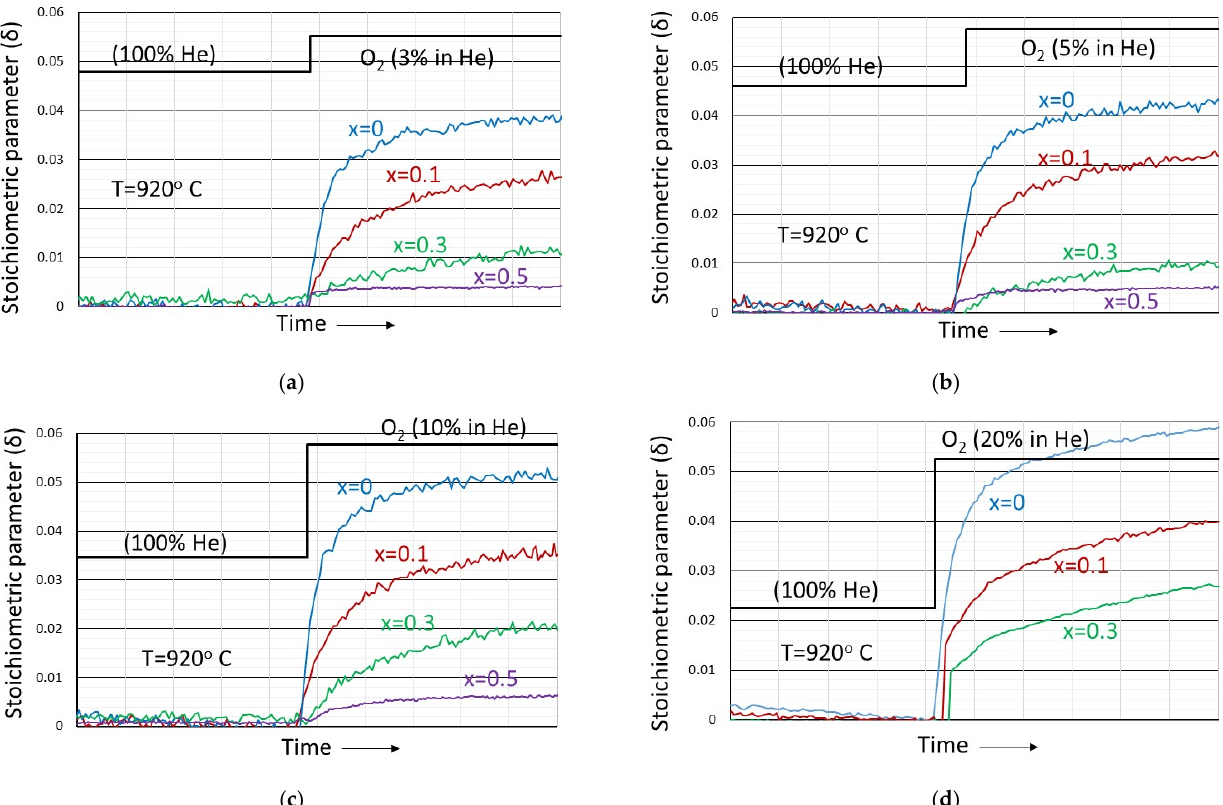
Figure 4. The dependence of the stoichiometric parameter δ in La 1- xSr x MnO 3+ δ perovskites initially equilibrated in helium at constant temperature, as a function of x for ( a ) 3% partial pressure of oxygen, ( b) 5% partial pressure of oxygen, ( c ) 10% partial pressure of oxygen and ( d ) 20% partial pressure of oxygen in